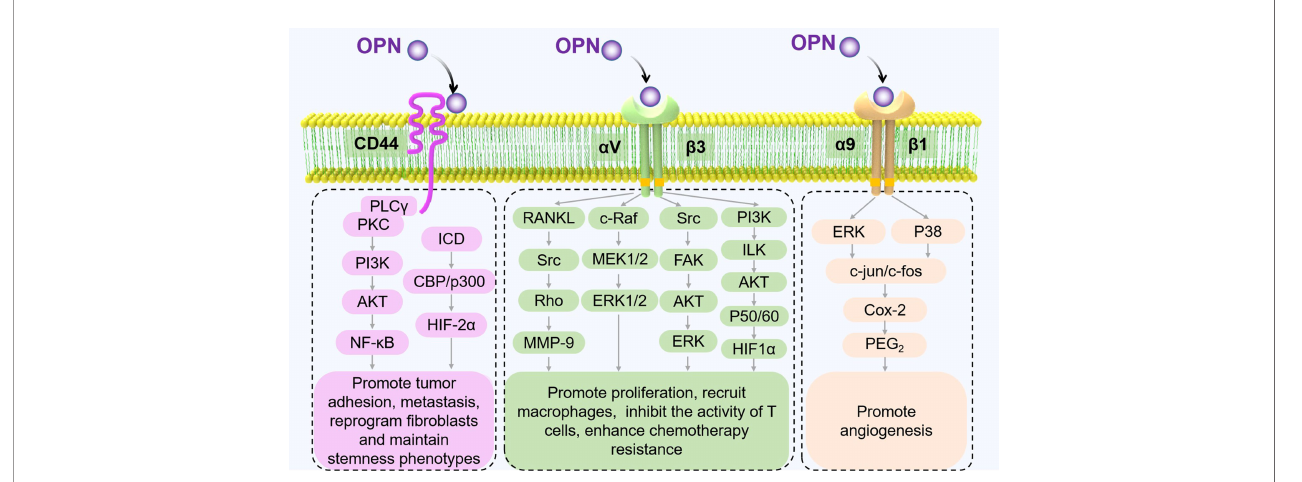
FIGURE 2 | Receptors of OPN and their signaling pathways in tumor progression. The different signaling pathways between OPN and its major receptors, CD44 and integrins, are shown to mediate pathological processes in TME (17, 35 –